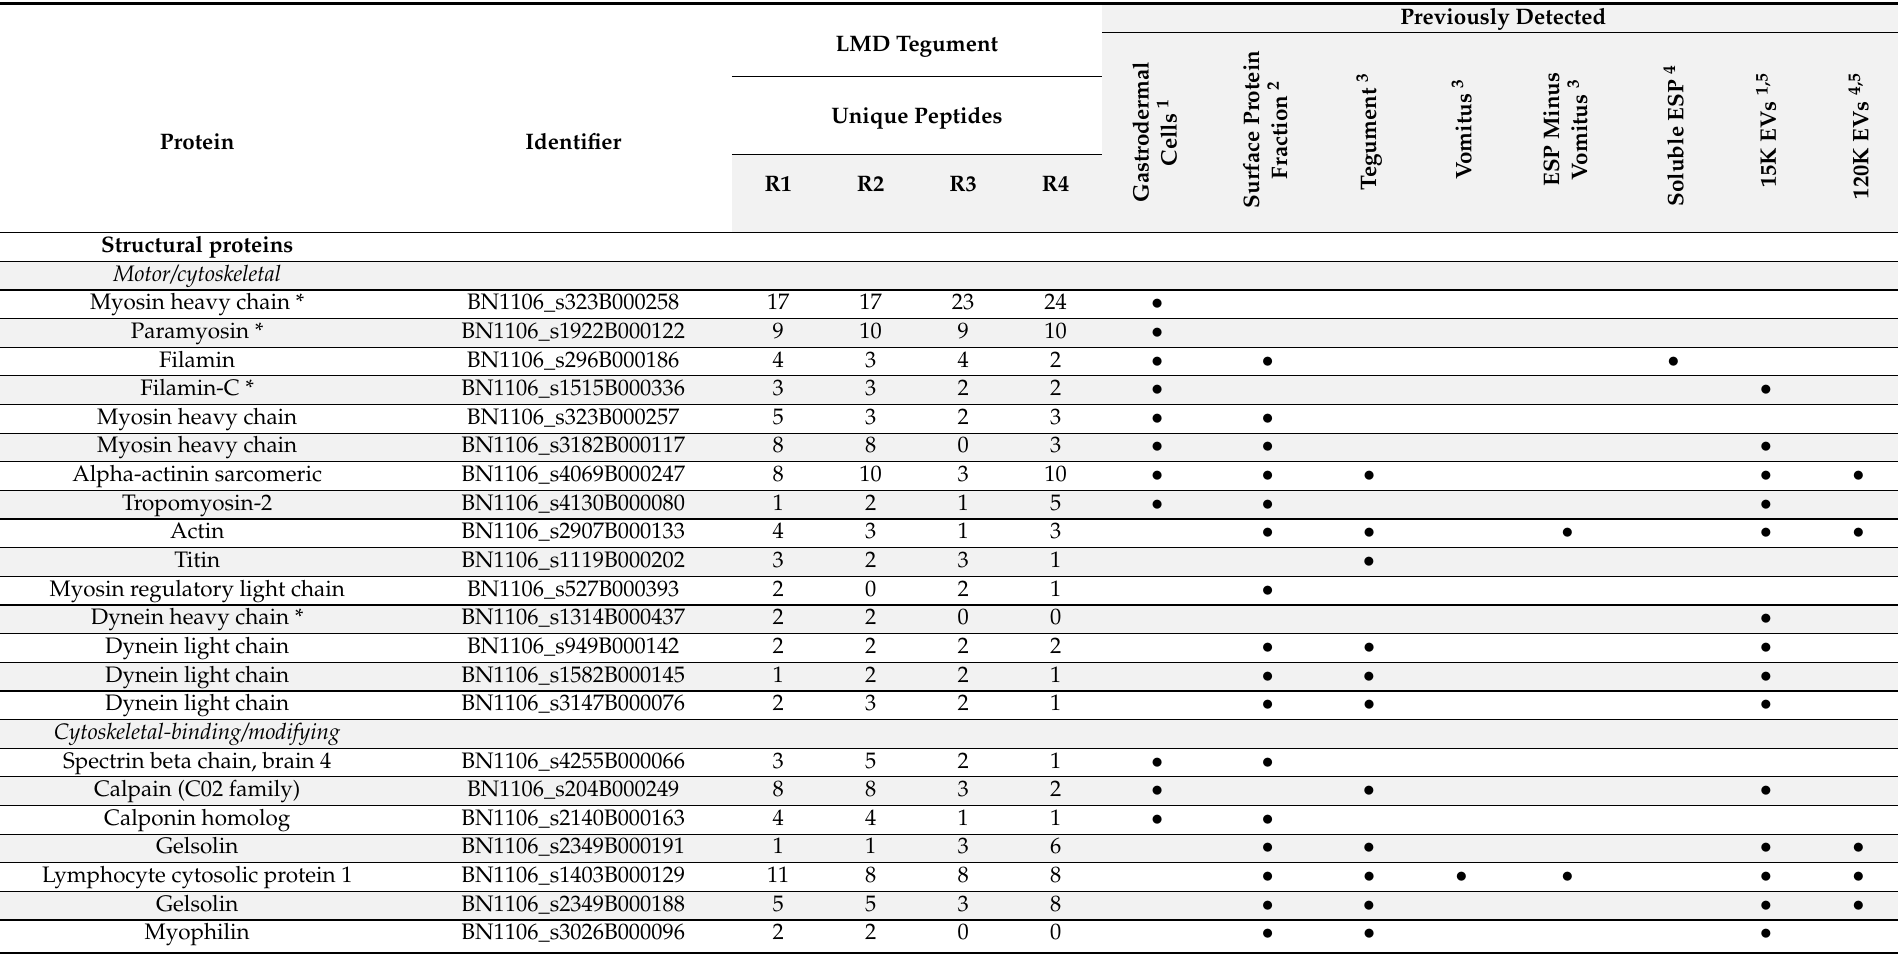
Table 2. Structural and signal transduction proteins identified in the laser microdissected (LMD) tegument of adult F. hepatica and compared with proteins identified in the gastrodermal cells (this study), as well as previously reported surface, tegument, and excretory/secretory proteins (ESP). A dot indicates a shared protein. Asterisks indicate the proteins that were not described in the previous F. hepatica tegument proteome dataset [22] or in the surface protein fraction (SPF) generated